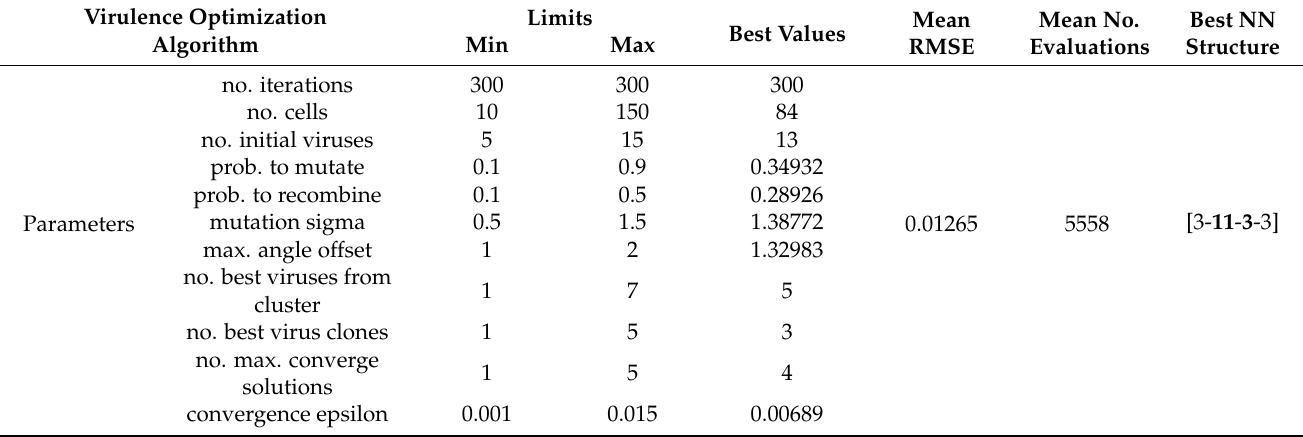
Table A7. The best results provided by the search procedure for the Virulence Optimization